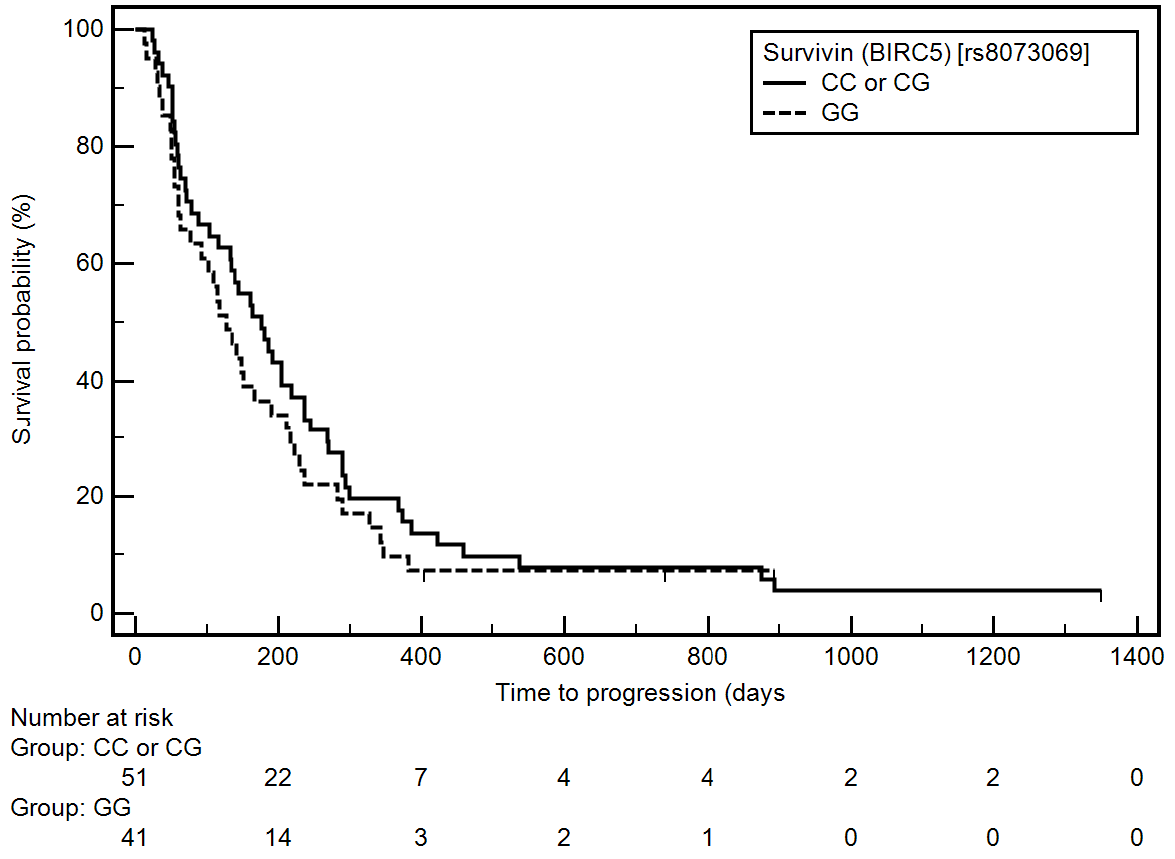
Figure 2. Kaplan–Meier curves representing probability of TTP shortening depending on BIRC5 genotype.